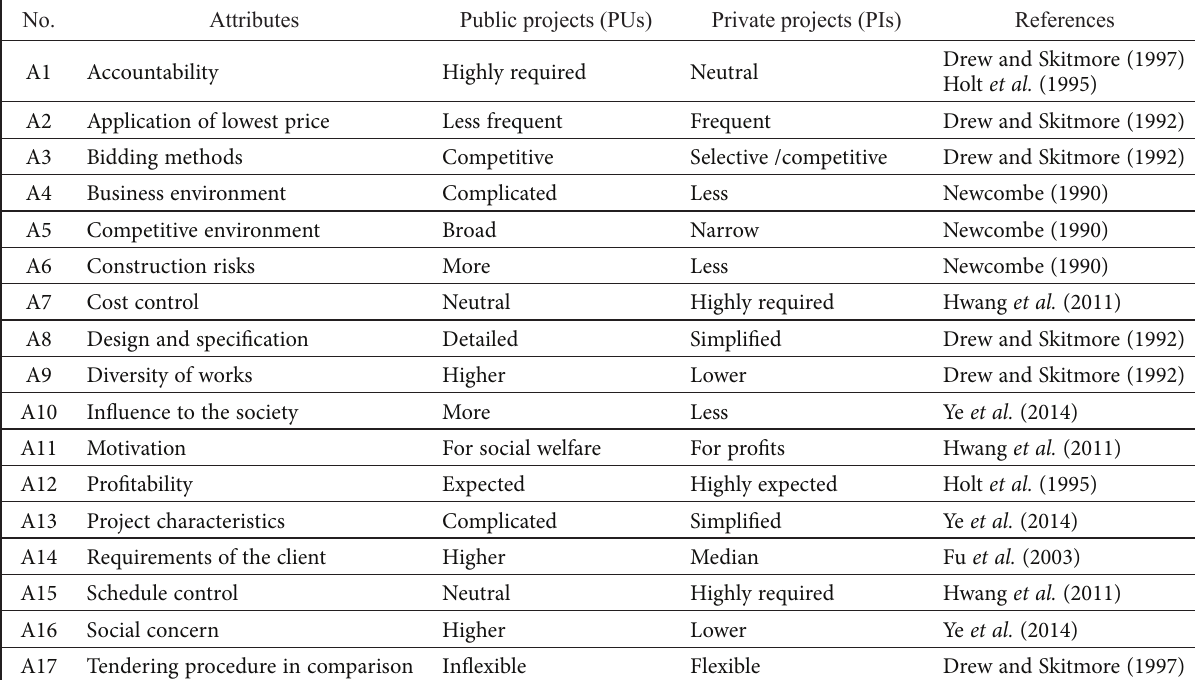
Table 2. Difference between public and private projects in attributes